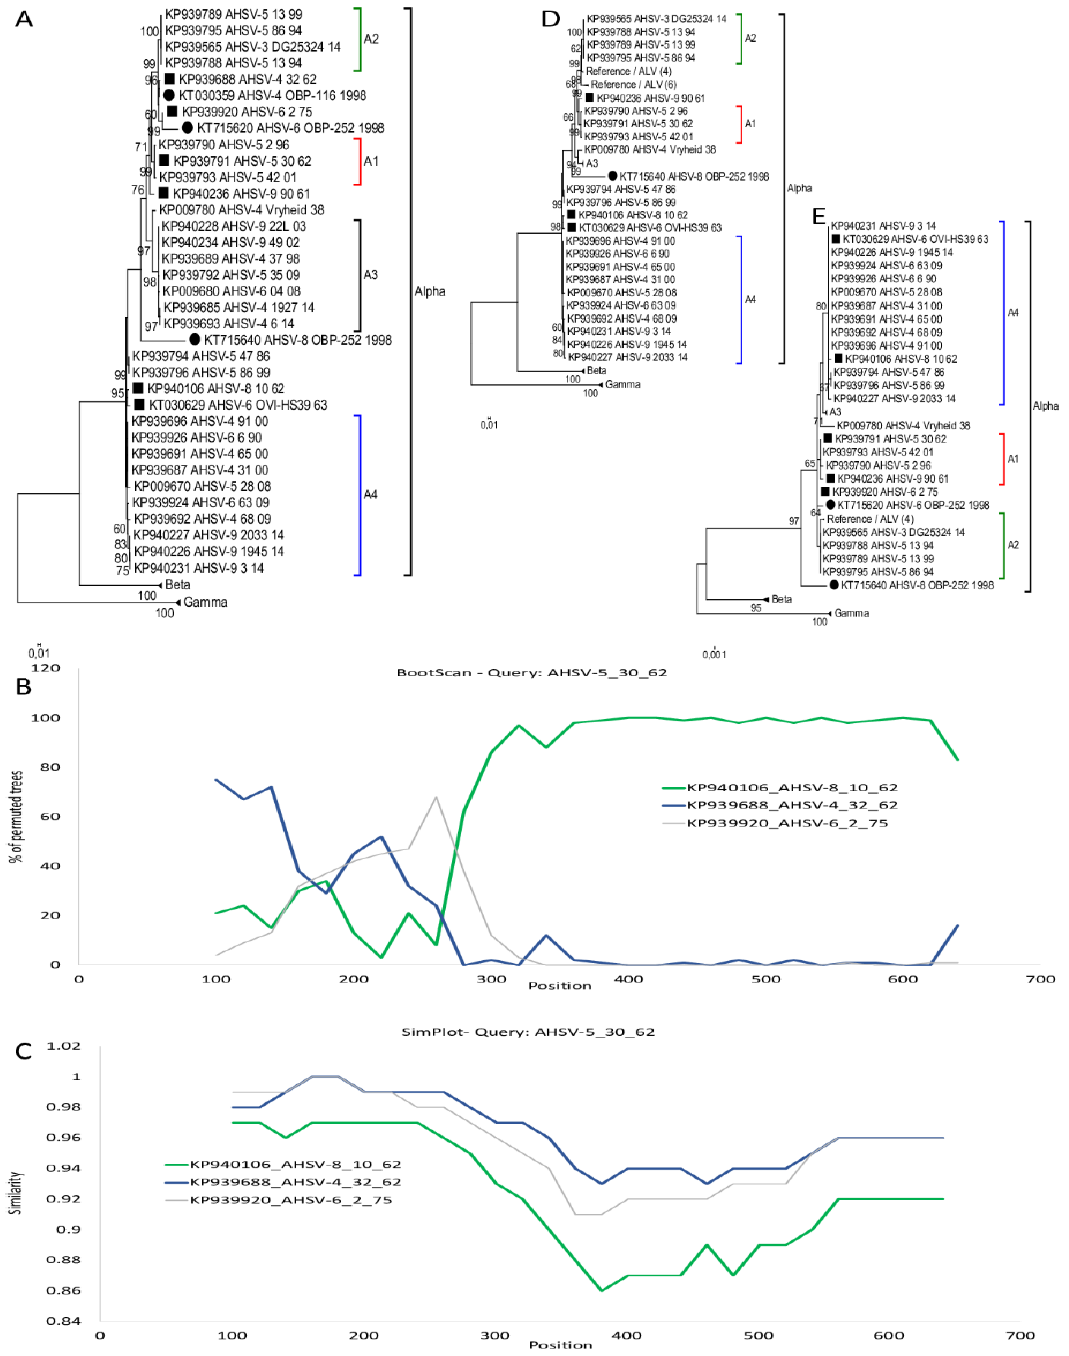
Figure 4. Predicted intragenic recombination in Segment-10 of KP939791_AHSV-5_30_62 (B2). ( A ) ML phylogenetic tree showing the relationship of segment-10 using selected African horse sickness virus (AHSV) sequences. Reference isolates are indicated with a square and attenuated live viruses (ALVs) with a circle. ( B ) BootScan results of KP939791_AHSV-5_30_62 with possible parents KP940106_AHSV-8_10_62 and KP39688_AHSV-4_32_62 and an outgroup KP939920_AHSV-6_2_72.